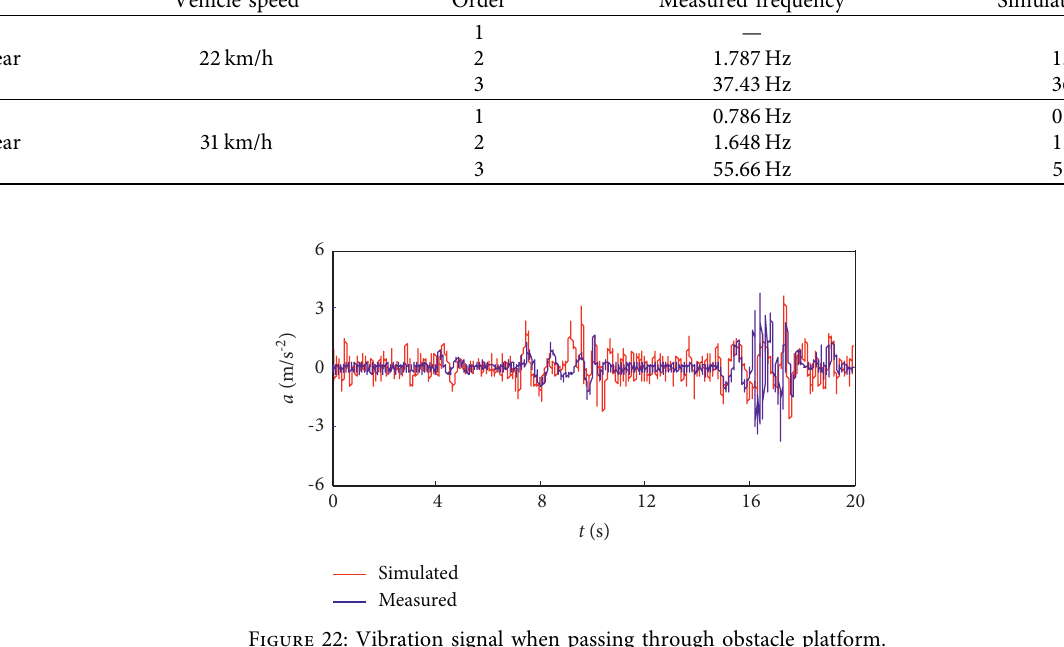
Table 12: Frequencies of the test vibration compared with the simulation values. Gear